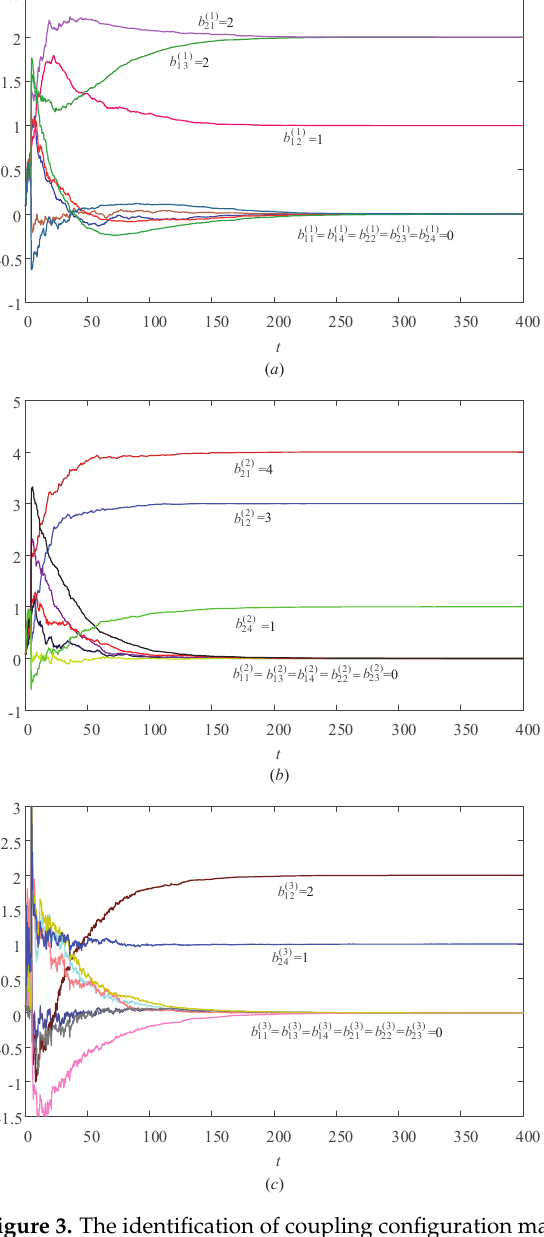
Figure 3. The identification of coupling configuration matrices ¯ A ( i ) ( i = 1,2,3 ) in (14).